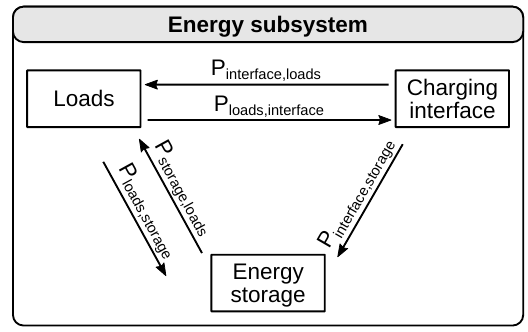
Figure A3. Energy flow model within energy